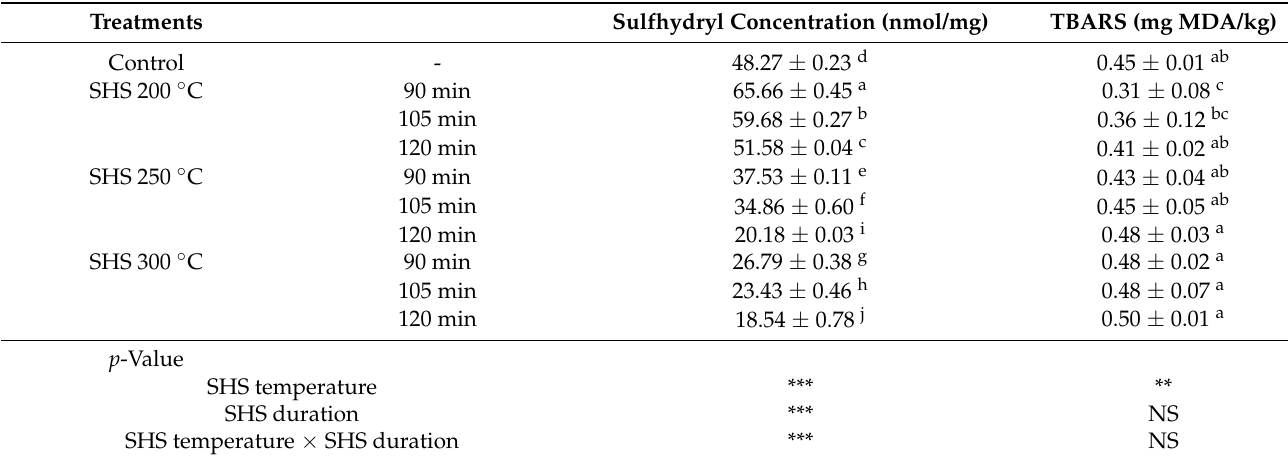
Table 3. Protein oxidation and lipid oxidation values of semi-dried restructured jerky processed with super-heated steam